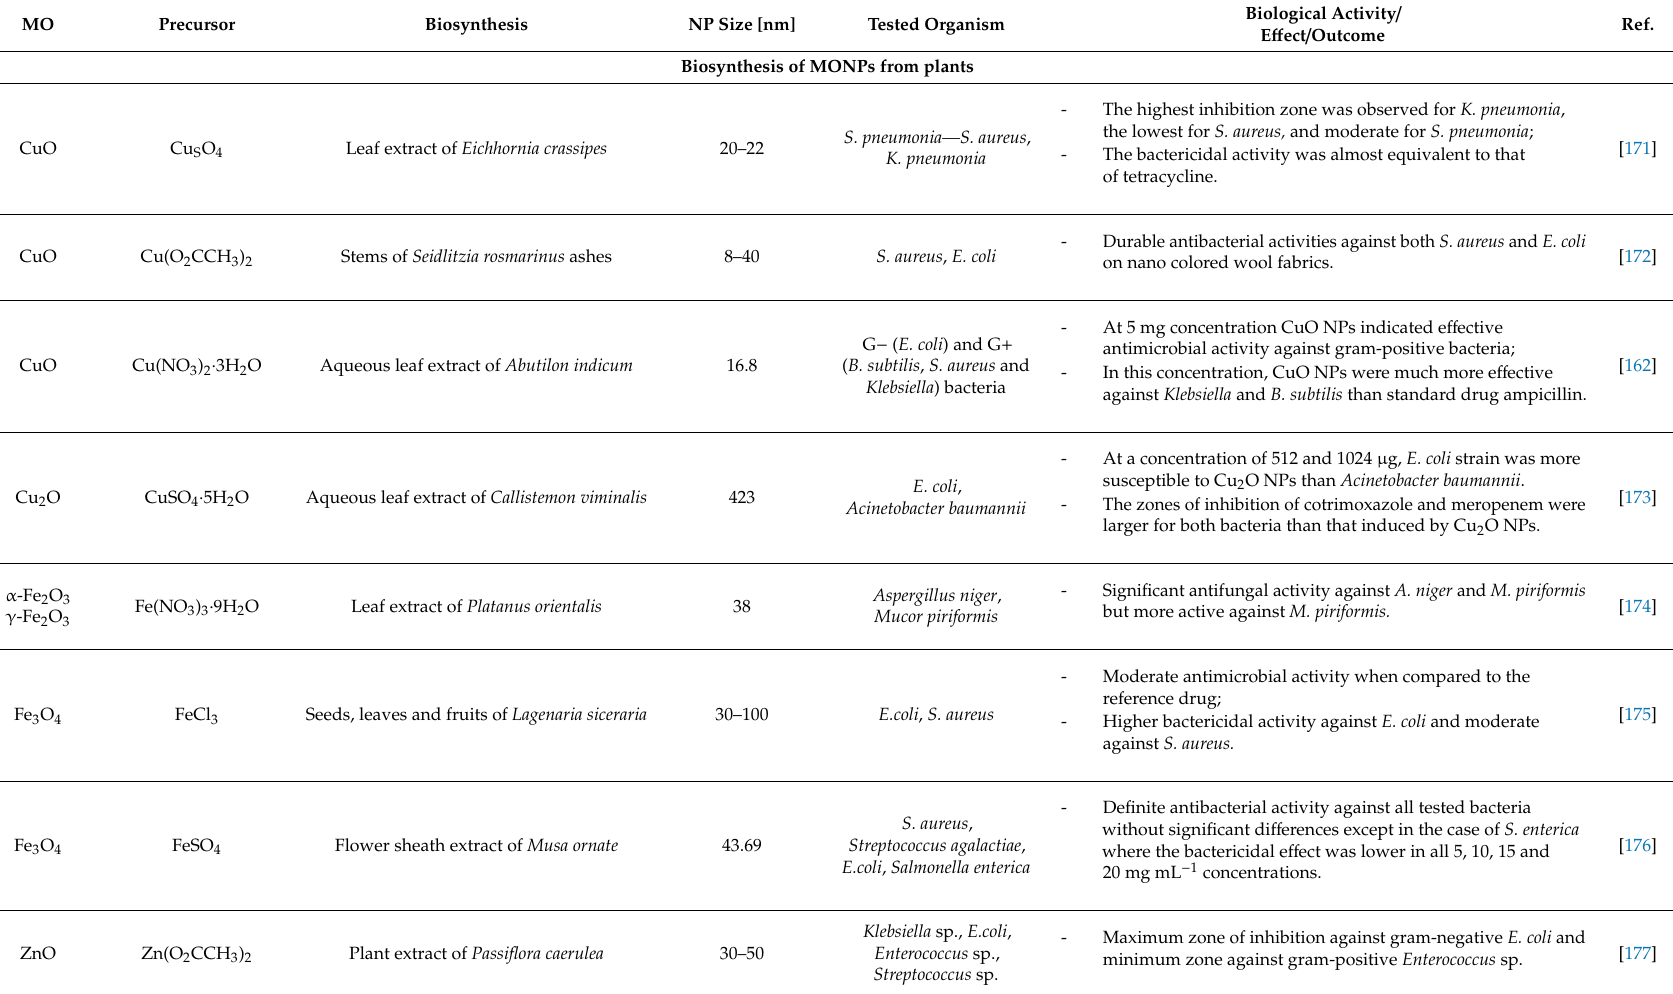
Table 1. Type, size, characteristics of the biosynthesis and activity of the MONPs against di ff erent tested